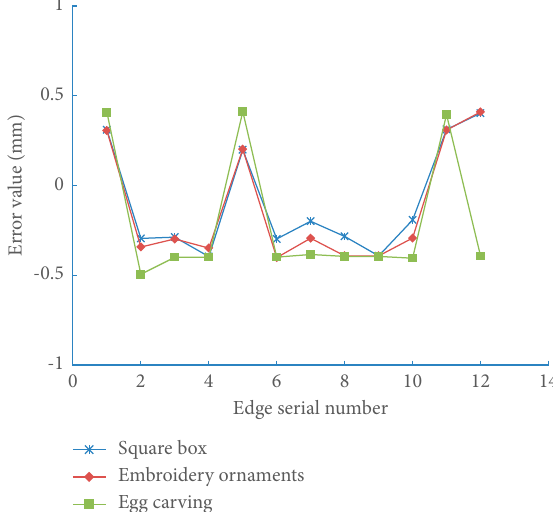
Figure 8: Error analysis of reconstruction result from 5 different shooting angles.